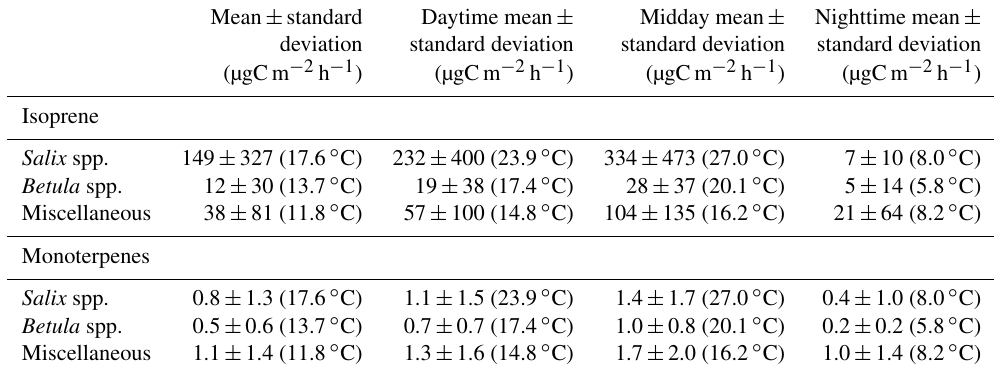
Table 3. Isoprene and monoterpenes (sum of α -pinene, β -pinene, limonene, and 1,8-cineole) surface emission rates per vegetation type. Miscellaneous refers to a mix of different species, including lichens and moss tundra (see Figs. S3–S15). Daytime refers to 10:00–20:00, midday to 11:00–14:00, and nighttime to 23:00–05:00 (Alaska standard time – UTC − 9). The values in parentheses represent the average enclosure temperature for each emission